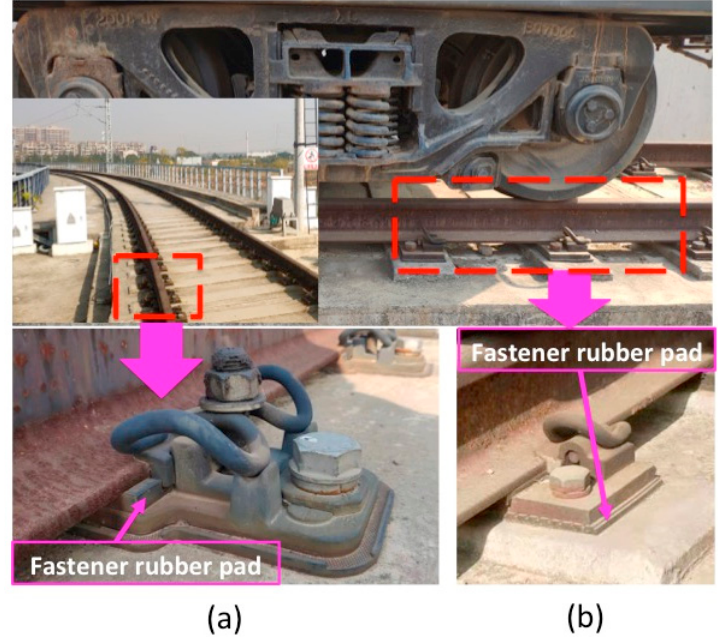
Figure 1. Details of the fastener rubber pad: ( a ) Fastener rubber pad of one fastener type; ( b ) Fastener rubber pad of another fastener type.